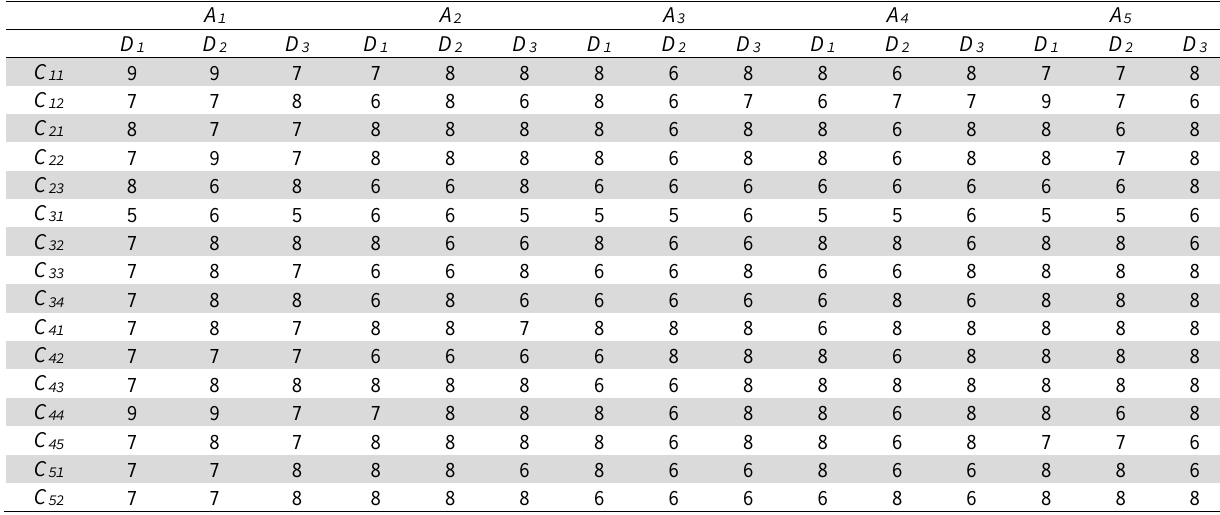
Decision matrix for TOPSIS